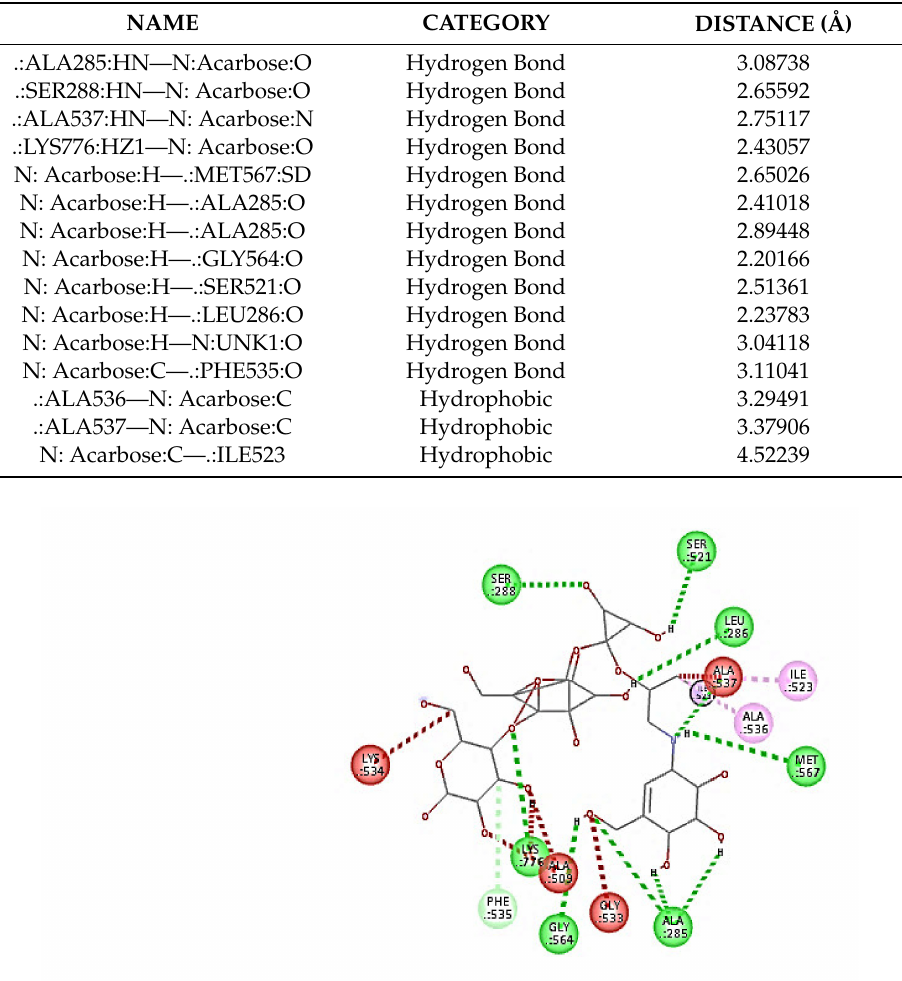
Table 4. Hydrogen and hydrophobic Interactions of acarbose and alpha-glucosidase.